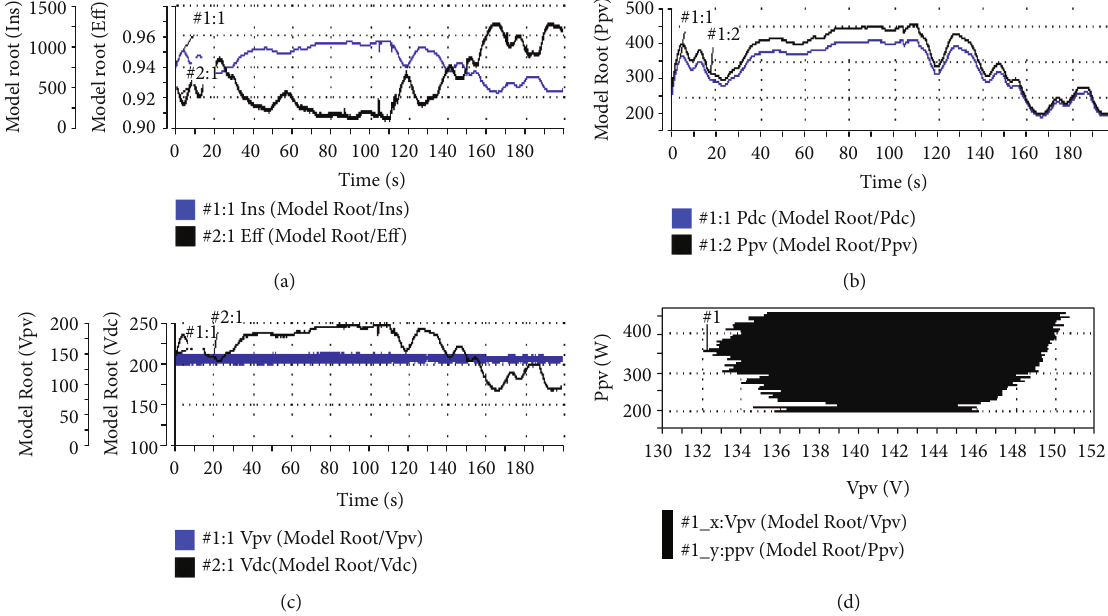
Figure 16: Experimental results of SVPWPS for new reference voltage and arbitrary scenario for insolation: (a) evolution of the insolation and the e ffi ciency of the DC/DC inverter; (b) variation of the input and output powers; (c) evolution of the input and output voltage of the boost converter; (d) movement of MPP versus the PV array voltage. Table 5: Experimental comparison between the proposed improved-FOCV and MPPT techniques based on classical algorithms.